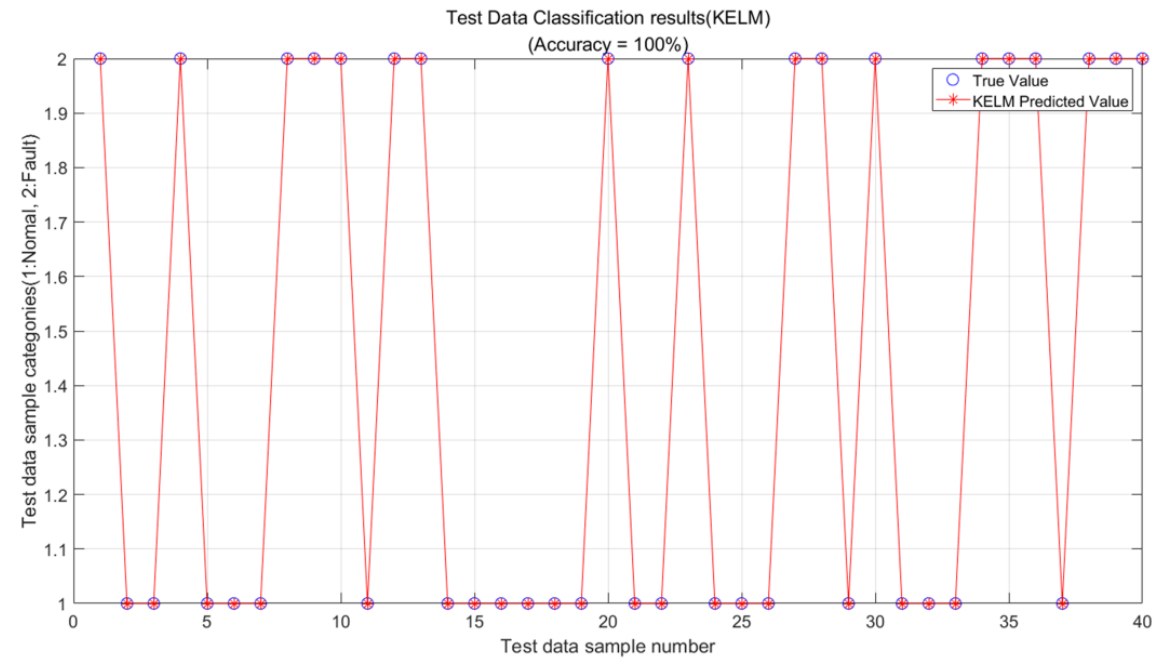
Figure 12. Comparison of the predicted and true values of the test data(KELM).